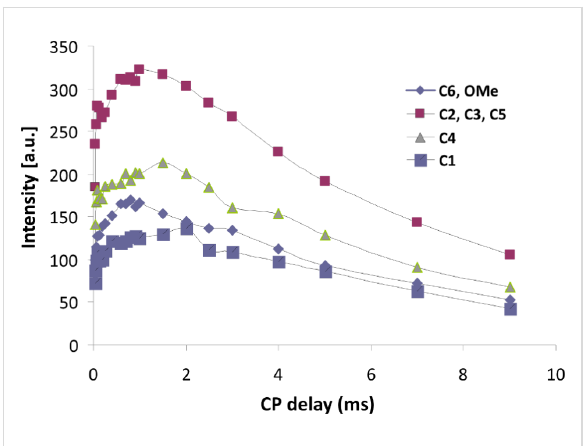
Figure 6: Cross-polymerization (CP) build-up curve of the 13 C reso- nances with variable contact times for the CRYSMEB sample.